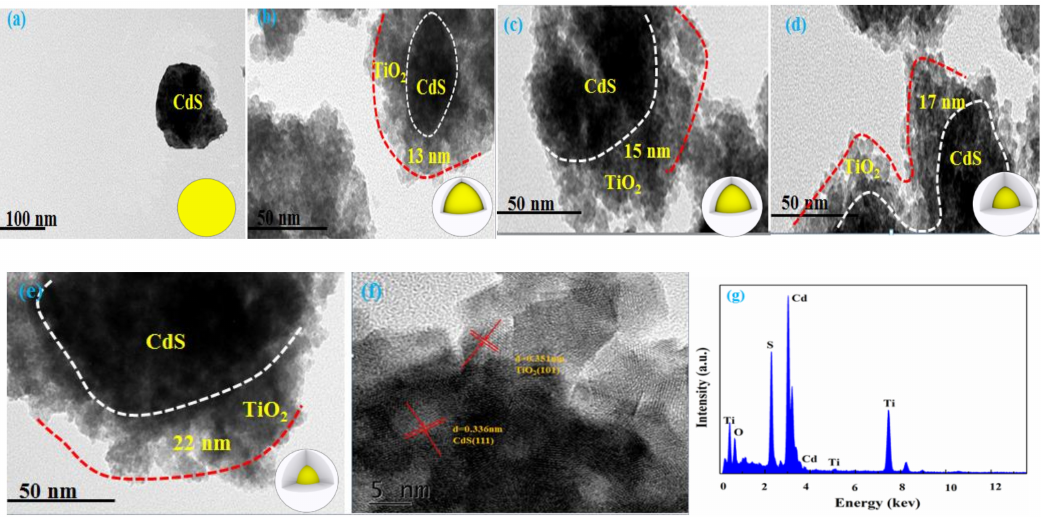
Figure 2. TEM images of CdS ( a ), 0.01CdS@TiO 2 ( b ), 0.05CdS@TiO 2 ( c ), 0.10CdS@TiO 2 ( d ), 0.15CdS@TiO 2 ( e ); HRTEM ( f ) and EDX ( g ) image of 0.10CdS@TiO 2